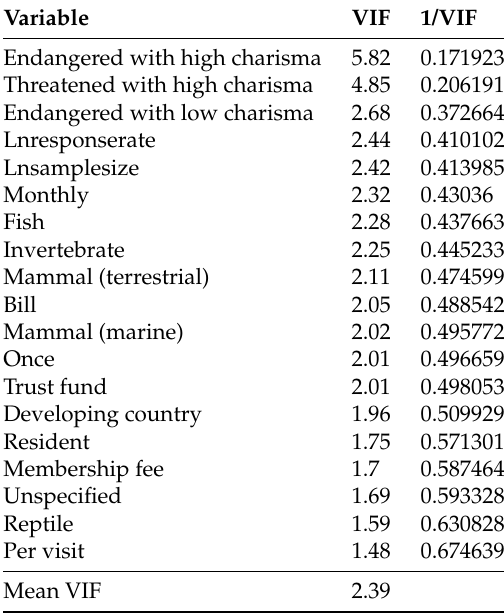
Table A2. Variance inflation factor (VIF) for model